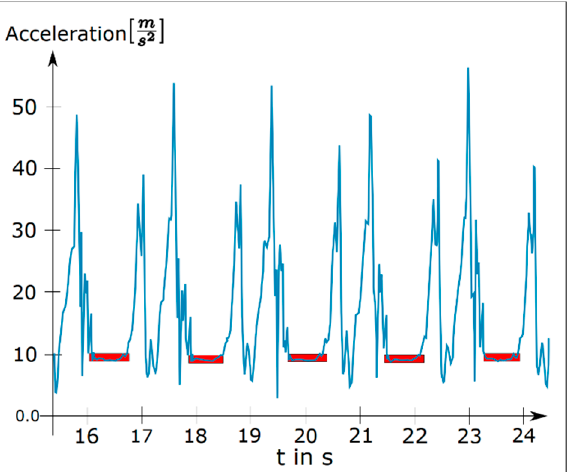
Figure 3. Total acceleration of one foot with detected resting periods (red).